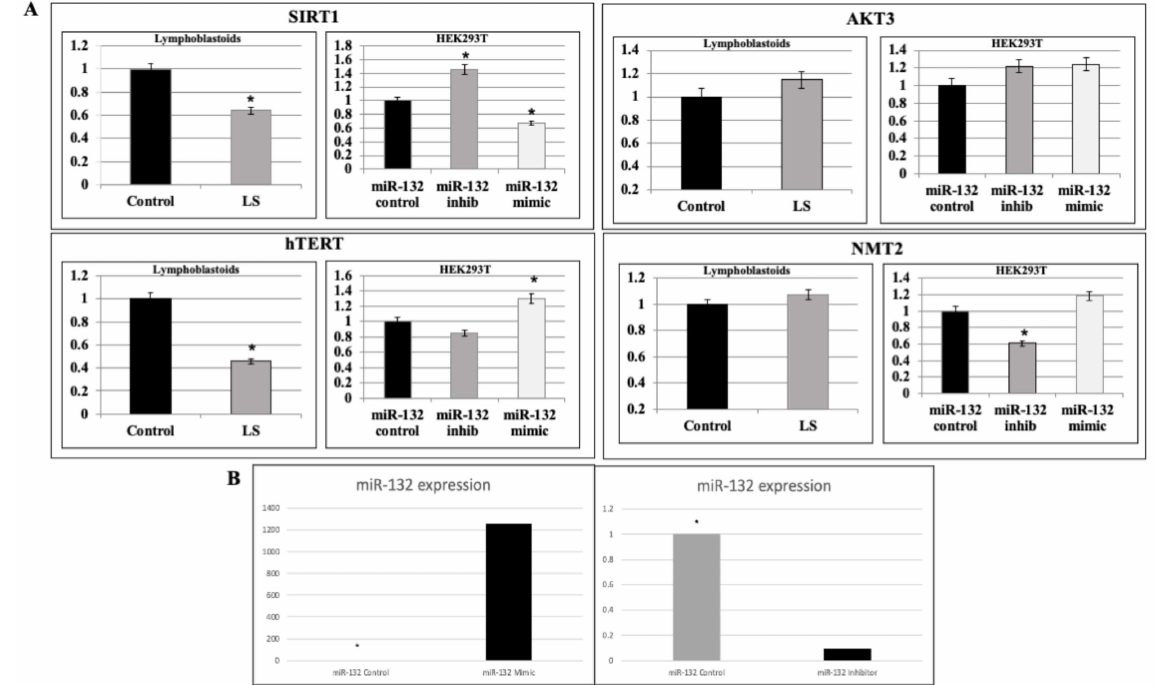
Figure 3. Expression of miR-132-3p target genes. ( A ) Total RNA was prepared from four individual LS patient-derived lymphoblastoid cultures and four control cultures. Levels of SIRT1, hTERT, AKT3 and NMT2 mRNAs were determined by qRT-PCR. For each of the four genes, the left panel represents measurements obtained in EBV-immortalized lymphoblastoid cell lines (solid bars, control cultures; gray bars, LS patients) and the right panel denotes measurents in mir Vana™ miRNA- transfected HEK293T cells. A value of 1 was given to the mRNA level in control cultures. HEK293T cells were transfected with mir Vana™ miRNA-132-3p inhibitor (gray bars) or mimics (open bars) for 24 h, after which, specific mRNA expression was assessed by qRT-PCR. A value of 1 was given to the specific mRNA levels in control-transfected cells (solid bars). * p < 0.01 versus respective control cells. ( B ) Expression of miR-132-3p in miR-132-3p inhibitor or mimic-transfected HEK293T cells. A value of 1 was given to the miR-132-3p levels in control-transfected